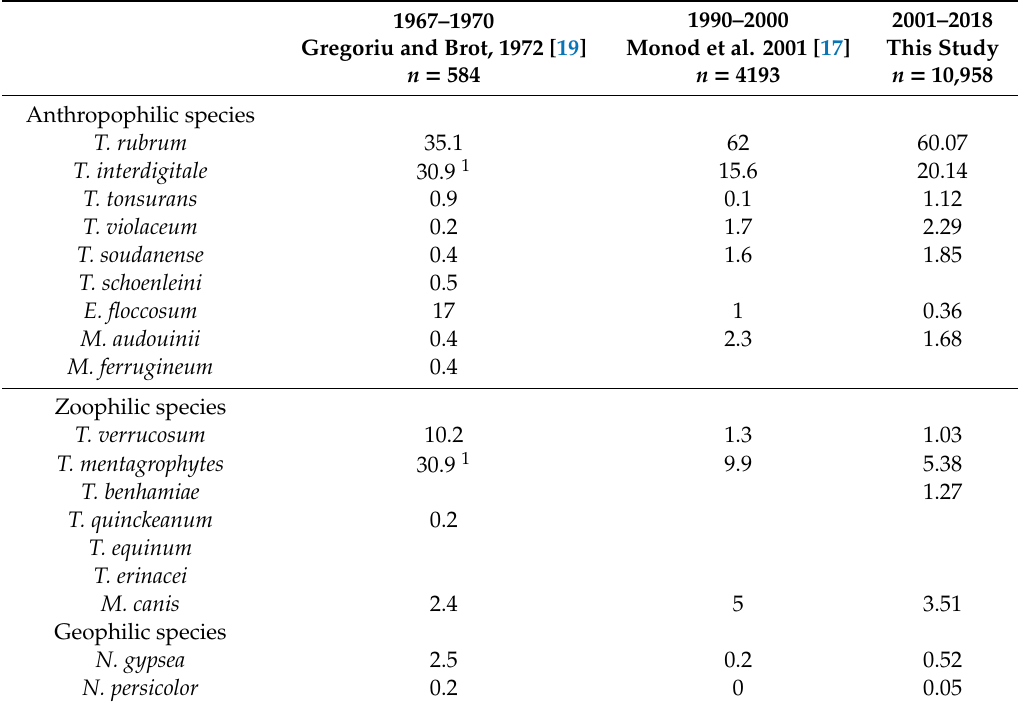
Table 3. Prevalence of dermatophyte species (%) from three di ff erent surveys during the last 50 years in